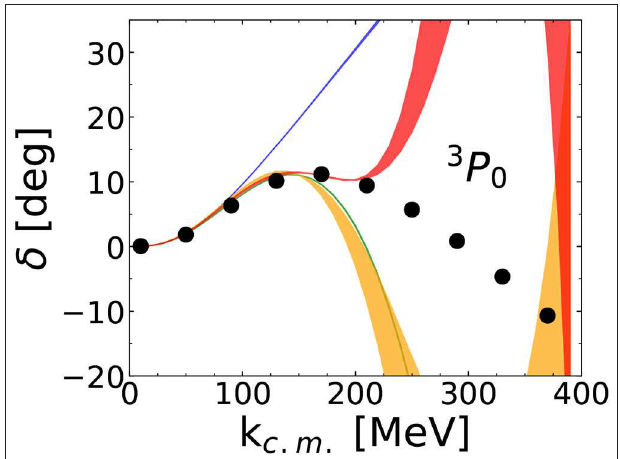
FIGURE 4 | Two-nucleon 3 P 0 phase shift δ as function of the center-of-mass momentum k c.m. . The NLO (blue), N 2 LO (green), N 3 LO (orange), and N 4 LO (red) bands from a perturbative treatment of pion exchange correspond to cutoff variation from 0.8 to 2.4 GeV. (LO in a perturbative expansion vanishes for this channel.) The empirical phase shifts from the SAID program [88] (solid circles) are shown for comparison. Reprinted figure with permission from reference [ 87]. Copyright (2019) by the American Physical